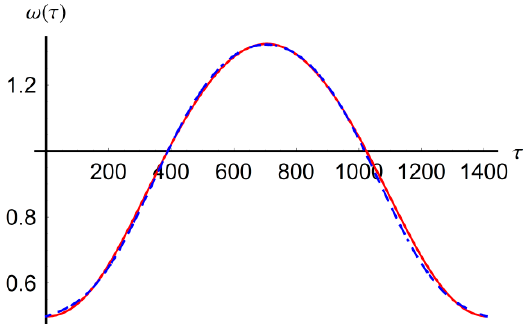
Figure 2. Comparison between the approximate solution and numerical integration results for i q :